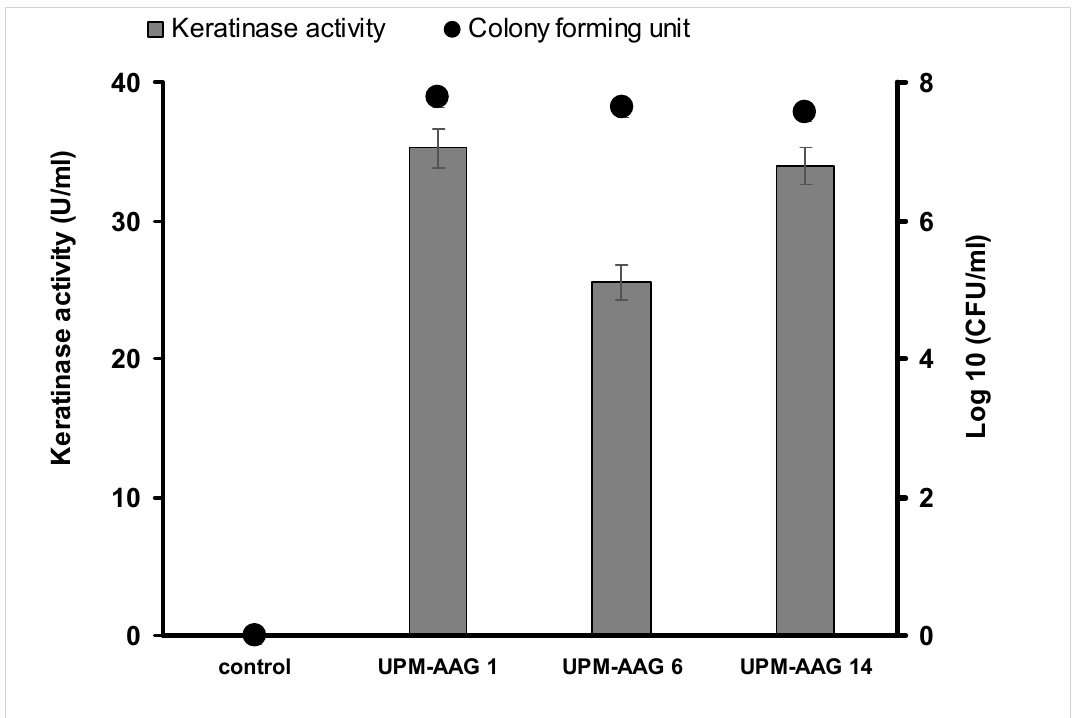
Figure 1. Screening result of three isolates with 1% feather. Error bars represent mean ± standard deviation (n = 3).